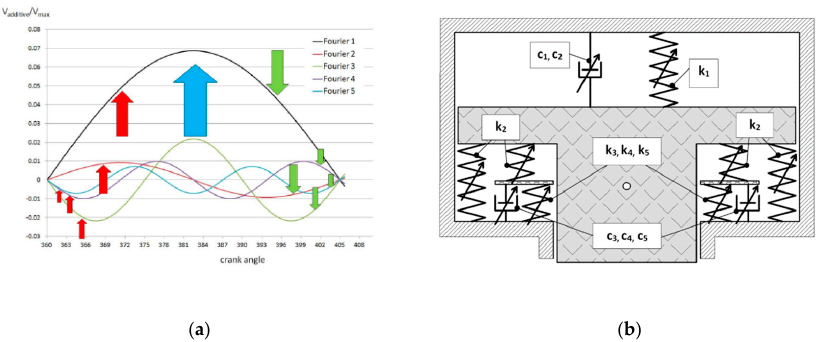
Figure 12. ( a ) Diagram of the five Fourier oscillations and the exciting and extinguishing forces. ( b ) model of the system realizing the oscillations in the system. All elements k 1 –k 5 and C 1 –C 5 from Figure 12b have been replaced with one symbolic spring, which should facilitate the analysis of the accumulation and recuperation process by the ACC system.